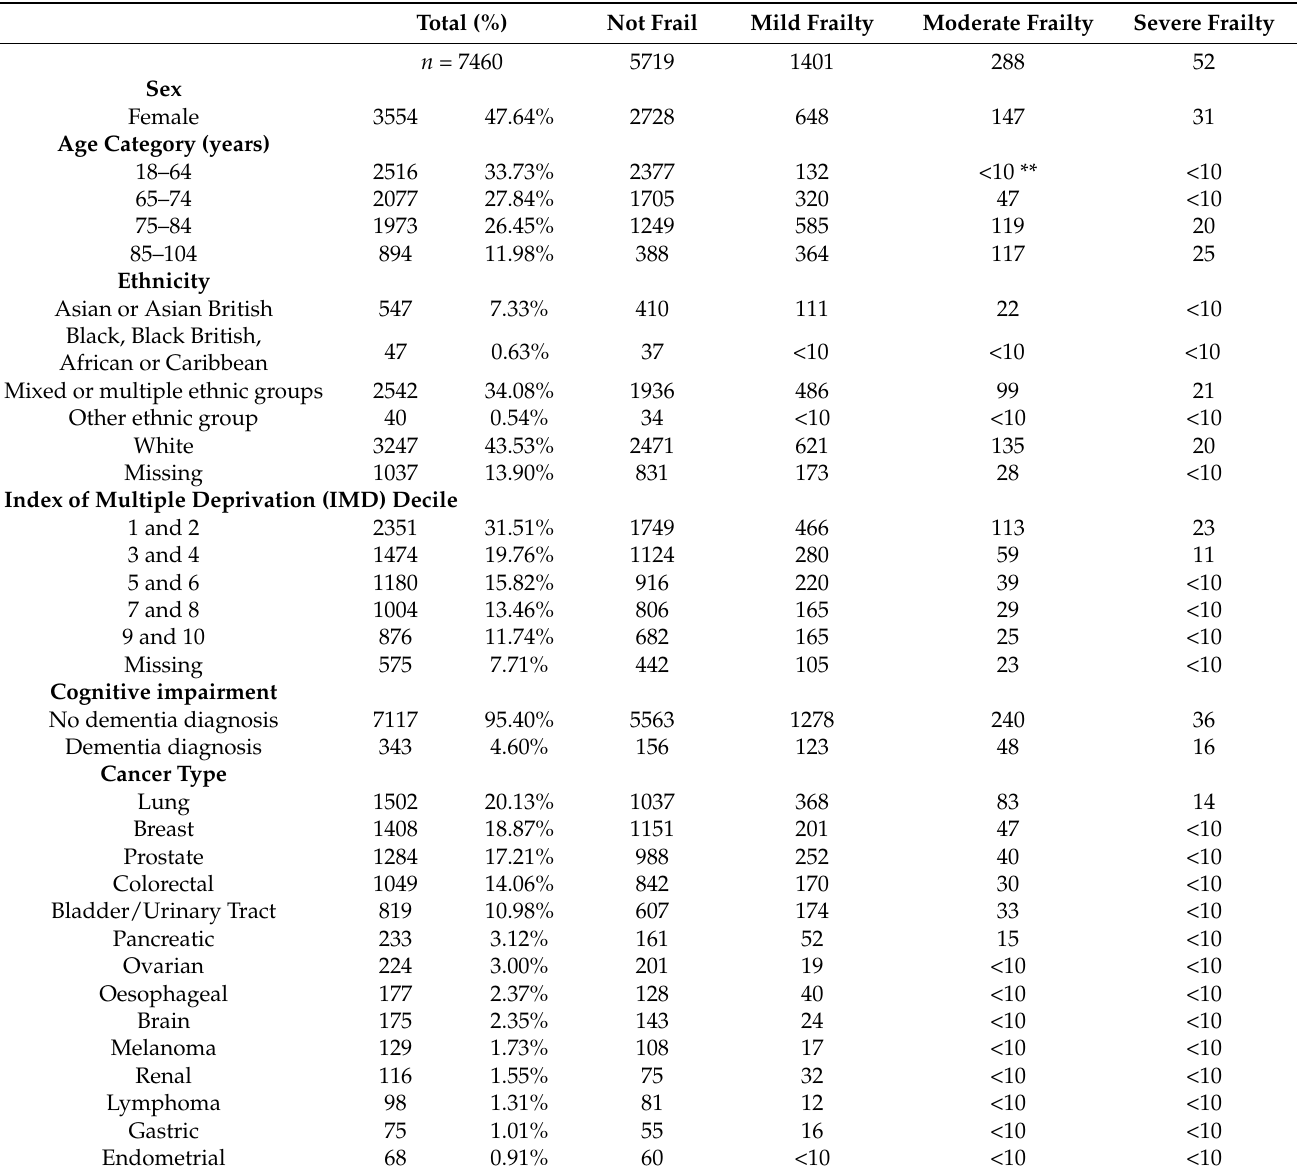
Table 1. Cohort demographics, categorised by level of